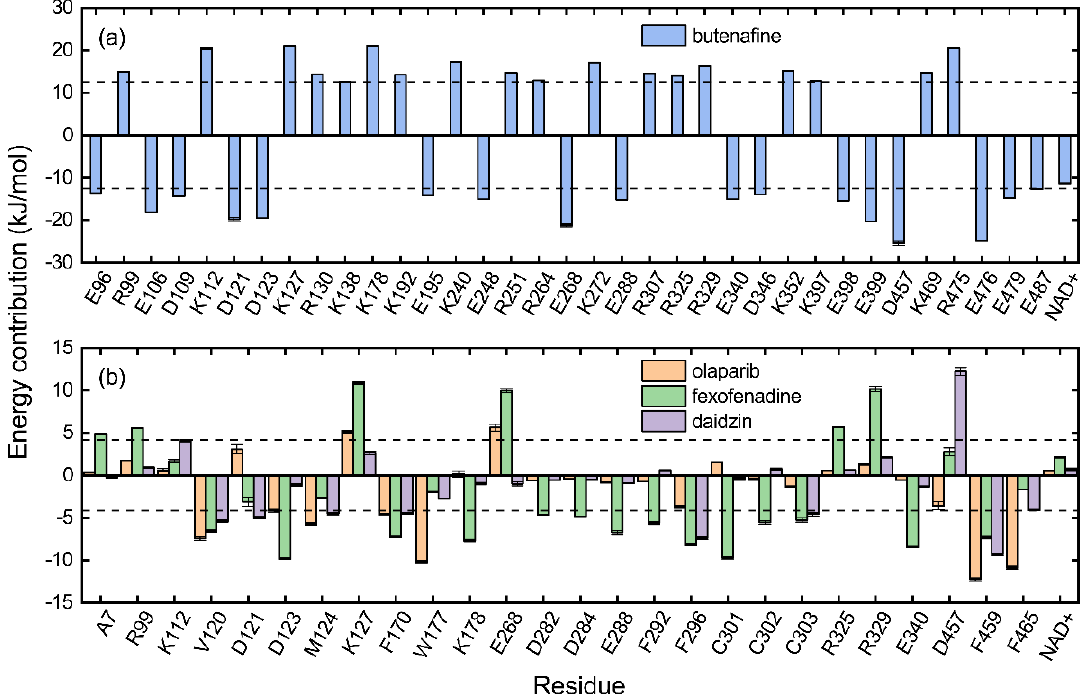
Figure 5. Energy contribution per residue to the binding of ALDH2 with potential inhibitors of butenafine, olaparib, fexofenadine, and daidzin. Each residue with a contribution of ≥ 16.8 kJ/mol is given for butenafine ( a ). For the other three compounds, the given residues have a contribution of ≥ 4.2 kJ/mol for at least one inhibitor ( b ). Dashed lines in panels ( a , b ) indicate the energy thresholds for key residue identifications. The cofactor NAD + is considered as one residue of the receptor and its contribution is presented as well.